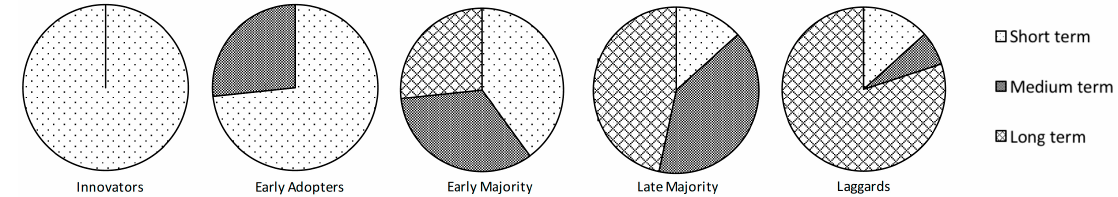
Figure 2. Stakeholder views on the adoption of citizen science initiatives in the scientific community. Short term: less than or equal to three years; Medium term: between three and five years; and Long term: between five and 15 years.